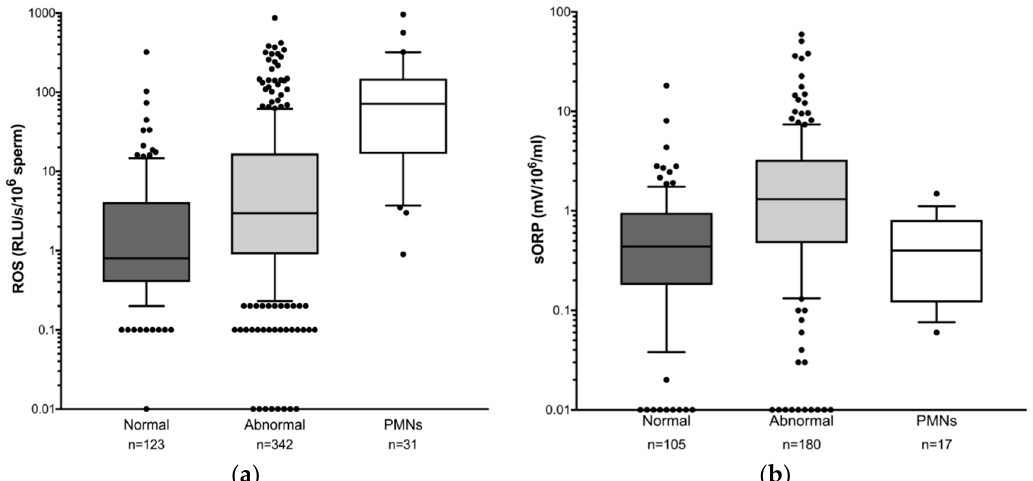
Figure 1. Box and whisker plots for seminal oxidative stress levels in different patient groups showing the median and interquartile ranges. Normal—normal semen parameters; Abnormal—abnormal parameters with <1 million/mL leukocytes; PMN—any parameters with ≥ 1 million/mL leukocytes. OS was measured using either ( a ) chemiluminescence (ROS) or ( b ) oxidation reduction potential (sORP) Lower whisker = 10th percentile; upper whisker = 90th percentile. Dots indicate values outside the range. Data are shown on a logarithmic scale.